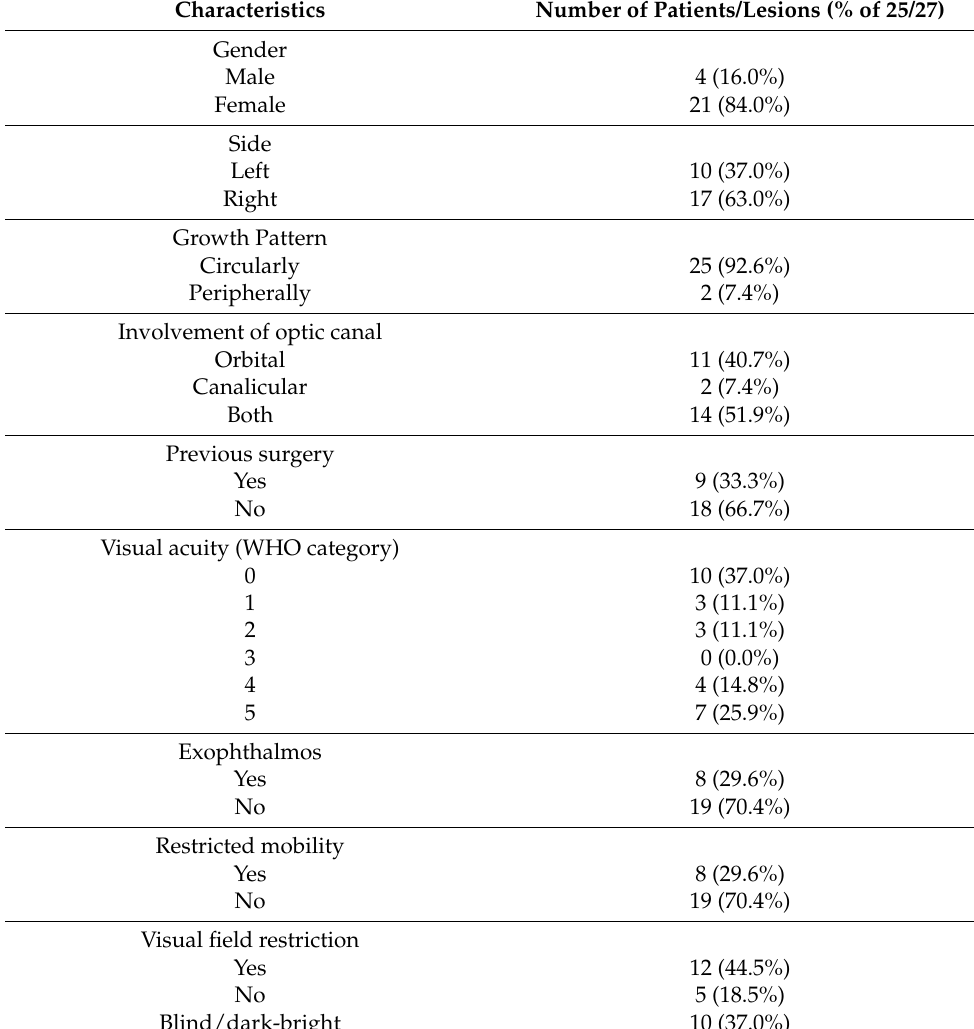
Table 1. Summary of clinical characteristics for 27 lesions in 25